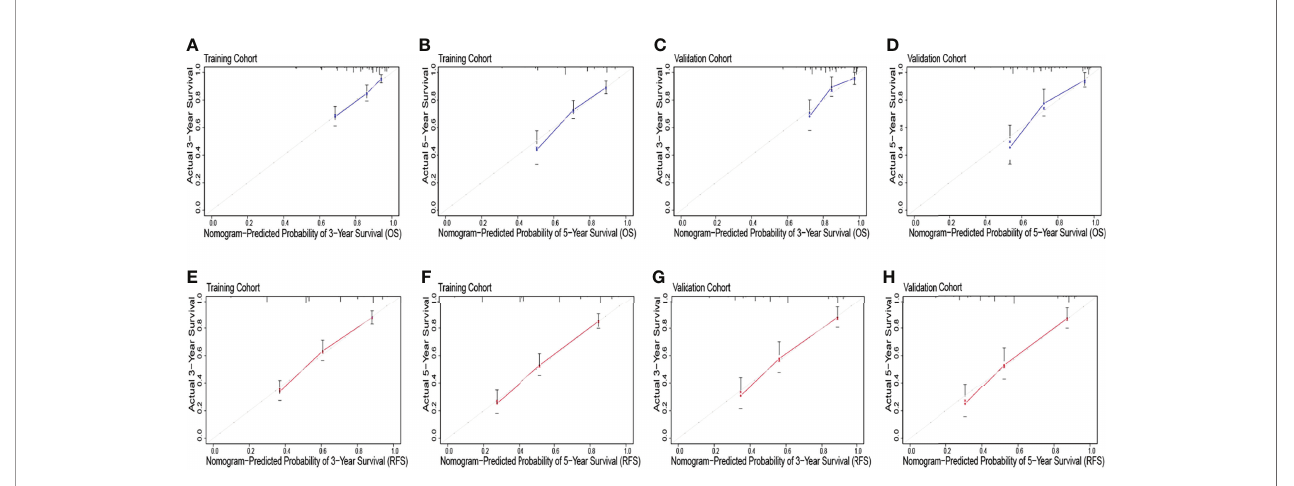
FIGURE 3 | The overall survival calibration curve for predicting patient survival at 3 years (A) and 5 years (B) in the training cohort and 3 years (C) and 5 years (D) in the validation cohort. The recurrence-free survival calibration curve for predicting patient survival at 3 years (E) and 5 years (F) in the training cohort and 3 years (G) and 5 years (H) in the validation